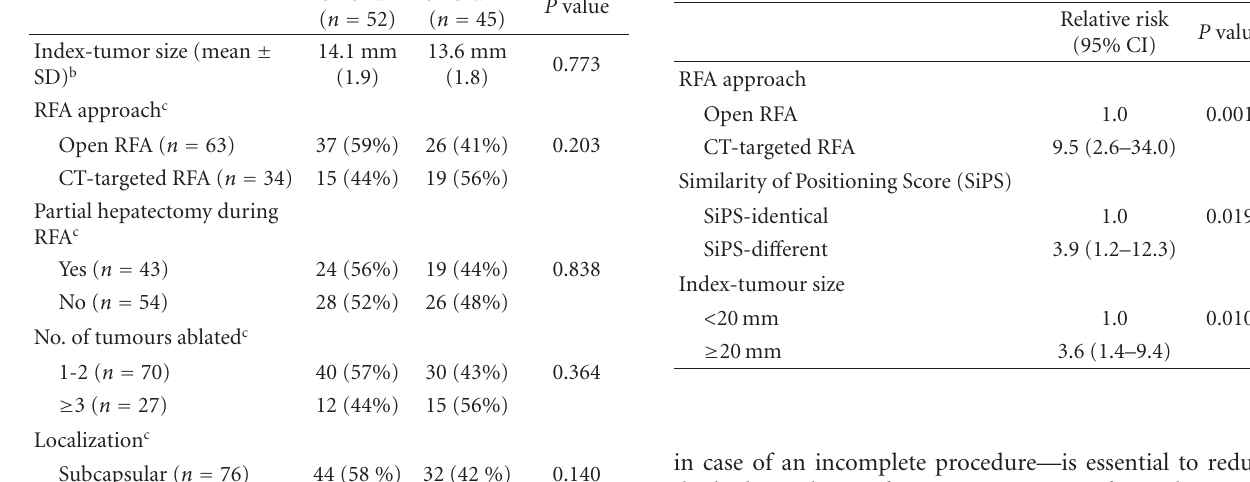
Table 3: Cox proportional hazard model showing the relative risk for development of ablation site recurrence compared to the reference standard